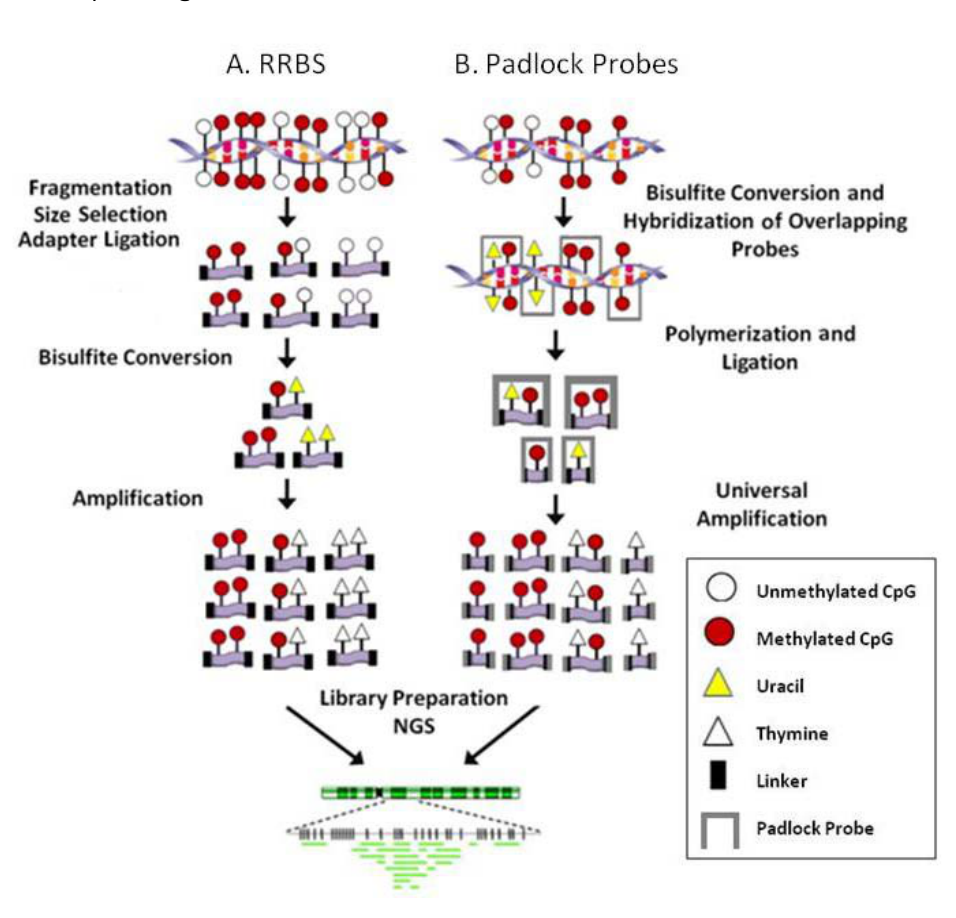
Figure 2. Site specific NGS methodologies. A. Reduced representation bisulfite sequencing (RRBS). B. Padlock probe assisted multiplex amplification. NGS: Next generation